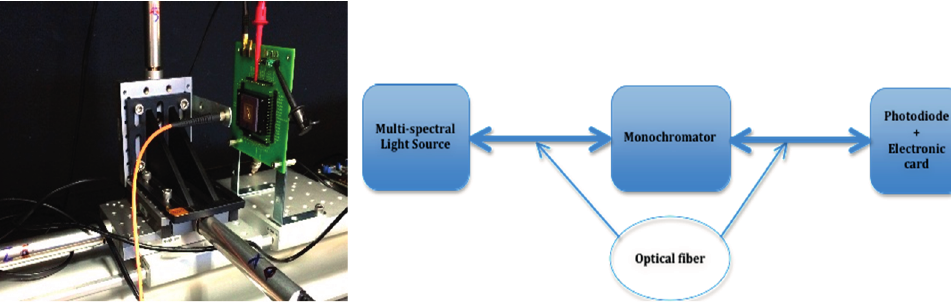
Figure 6. The test bench used for photodiode characterization in